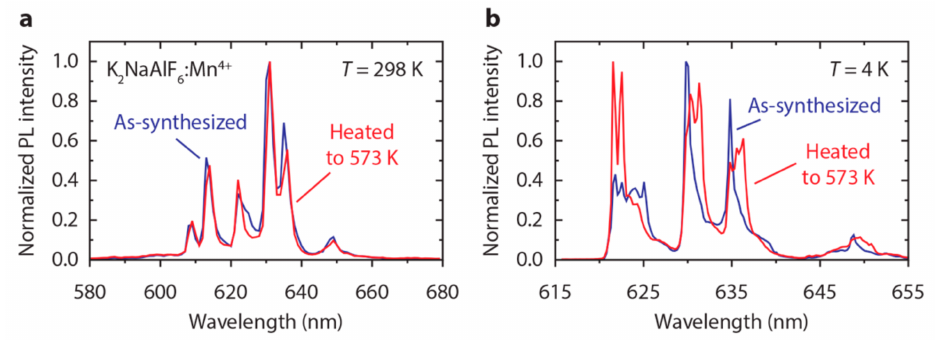
Figure 7. ( a ) Room-temperature emission spectra ( λ exc = 450 nm) of K 2 NaAlF 6 :Mn 4+ (0.9%) for as-synthesized K 2 NaAlF 6 :Mn 4+ phosphor (blue) and K 2 NaAlF 6 :Mn 4+ phosphor that has been heated to 573 K (red); ( b ) Emission spectra of K 2 NaAlF 6 :Mn 4+ (0.9%) at T = 4 K ( λ exc = 460 nm) for as-synthesized K 2 NaAlF 6 :Mn 4+ phosphor (blue) and K 2 NaAlF 6 :Mn 4+ phosphor that has been heated to 573 K